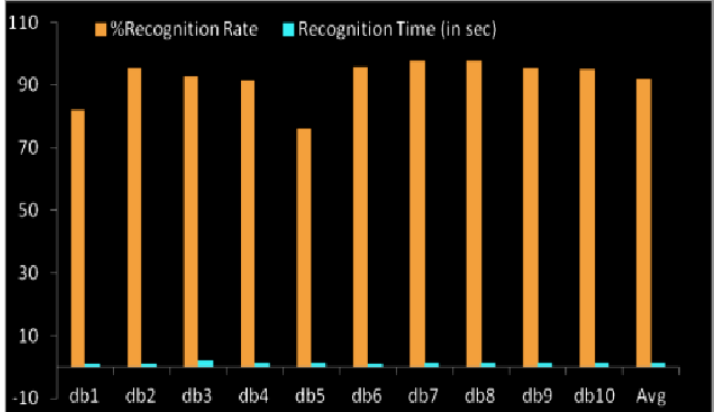
Figure 8. Recognition rate and recognition time using different Daubechies wavelets for handwritten numerals